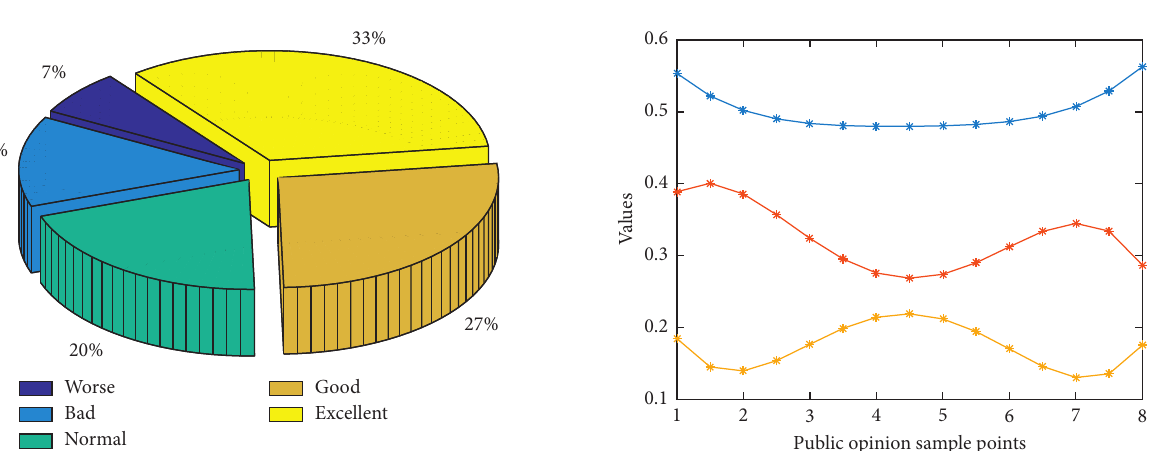
Figure 9: The distribution prediction fitting curve of different attitudes of the public policy and public opinion.